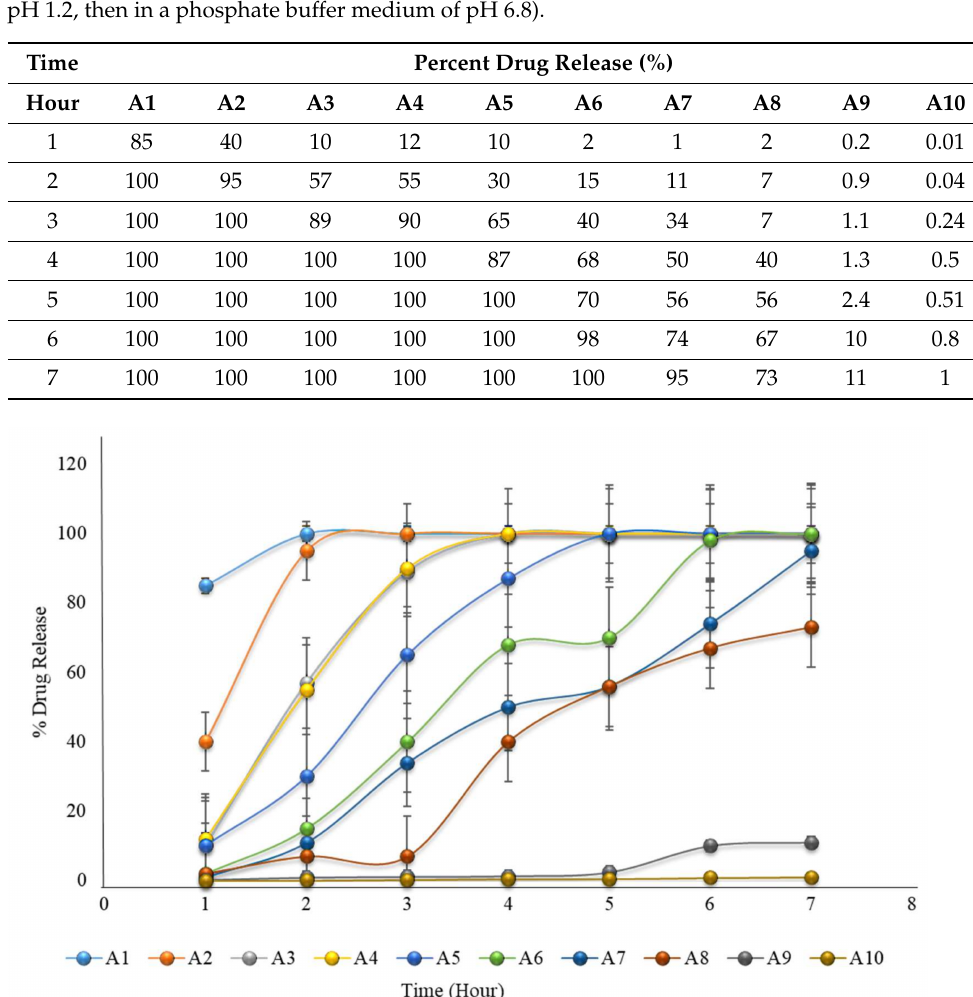
Figure 2. The in vitro dissolution of formulations A1 to A10 (the first 2 h in an acidic medium of pH 1.2, and then in a phosphate buffer medium of pH 6.8) showing that none of the formulations met the expected criteria for pulsatile drug